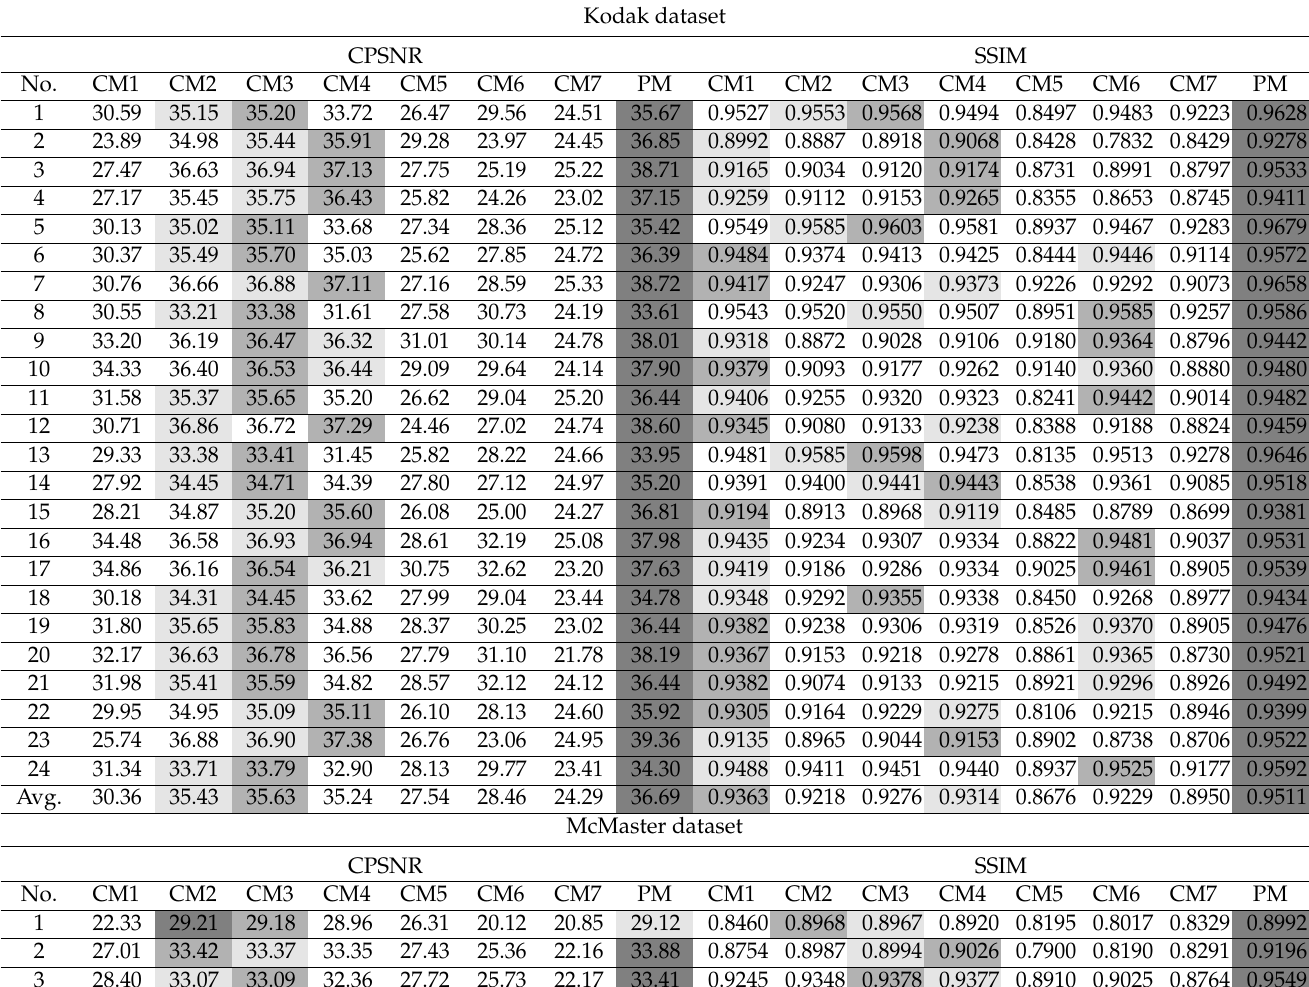
Table 1. Objective Performance Comparison of the Kodak 24 and McMaster 18 Images in CPSNR (dB) and SSIM for Crosstalk Degradation 1 (crosstalk kernel with σ g = 0.45 and noise with σ n =